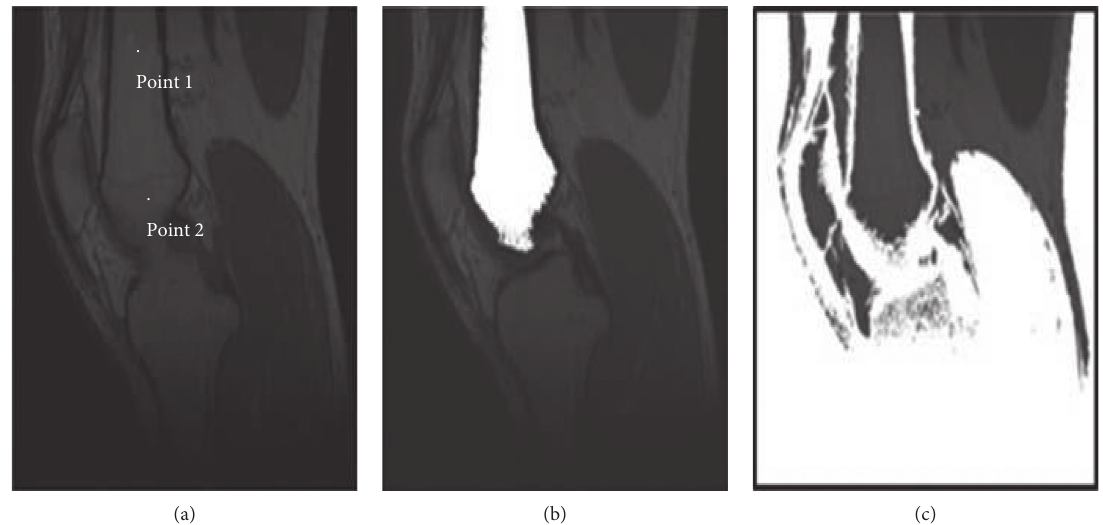
Figure 6: (a) Initial image with two seed points. (b) Outcome of region growing for one seed point. (c) Outcome of region growing for two seed